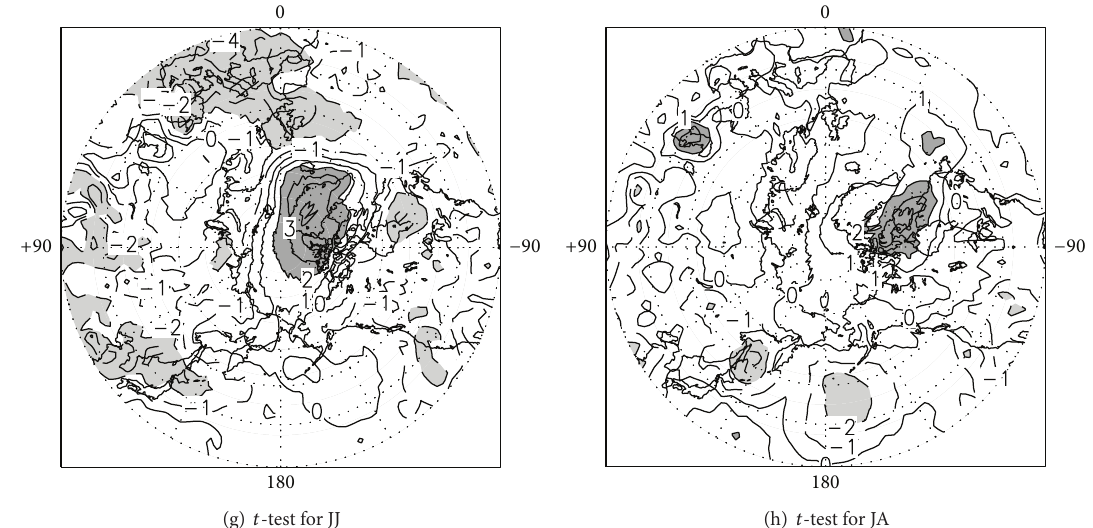
Figure 7: The anomaly distributions of SLP in July and August and their associations with the 10 highest and 10 lowest JJ and JA SIE cases over the north of 30 ∘ N: (a) a 30 yr SLP average in July for 1981–2010, (b) a 30 yr SLP average in August for 1981–2010, (c) departure of average SLP in July for the 10 highest JJ SIE cases relative to the 30 yr average SLP in (a), (d) departure of average SLP in August for the 10 highest JA SIE cases relative to the 30 yr average SLP in (b), (e) as in (c) but for the 10 lowest JJ SIE cases, (f) as in (d) but for the 10 lowest JA SIE cases, (g) Student’s 𝑡 -test scores of SLP in July for 10 highest and 10 lowest JJ SIE cases, and (h) as in (g) but in August for 10 highest and 10 lowest JA SIE